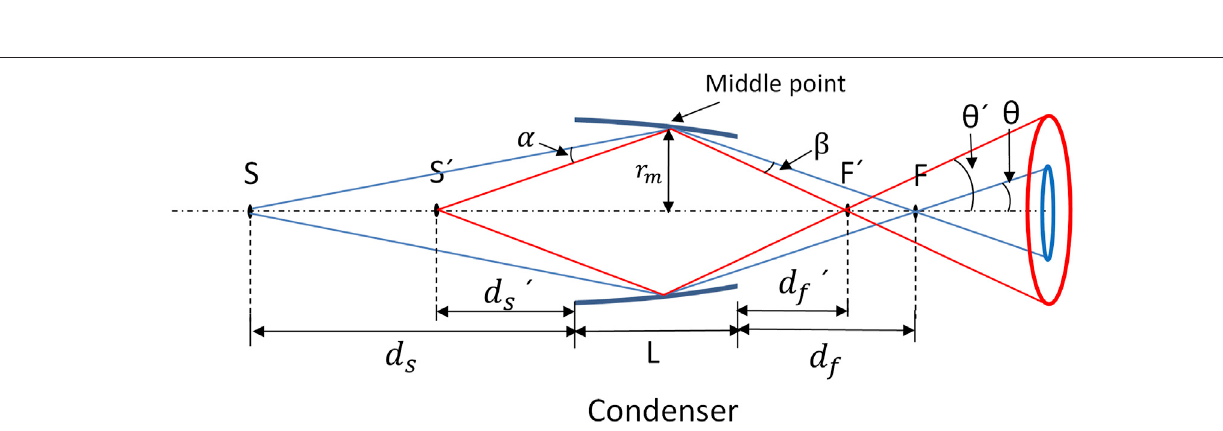
FIGURE 4 | Optical measurement results of an MXRL used as a condenser. (A) Ratio of OD/ID versus OD of the embryo tube. (B) Measured (dotted curve) and design ID (solid curve) pro fi le of the MXRL. (C) Diameter error of the MXRL. (D) Center line deviation of the MXRL.